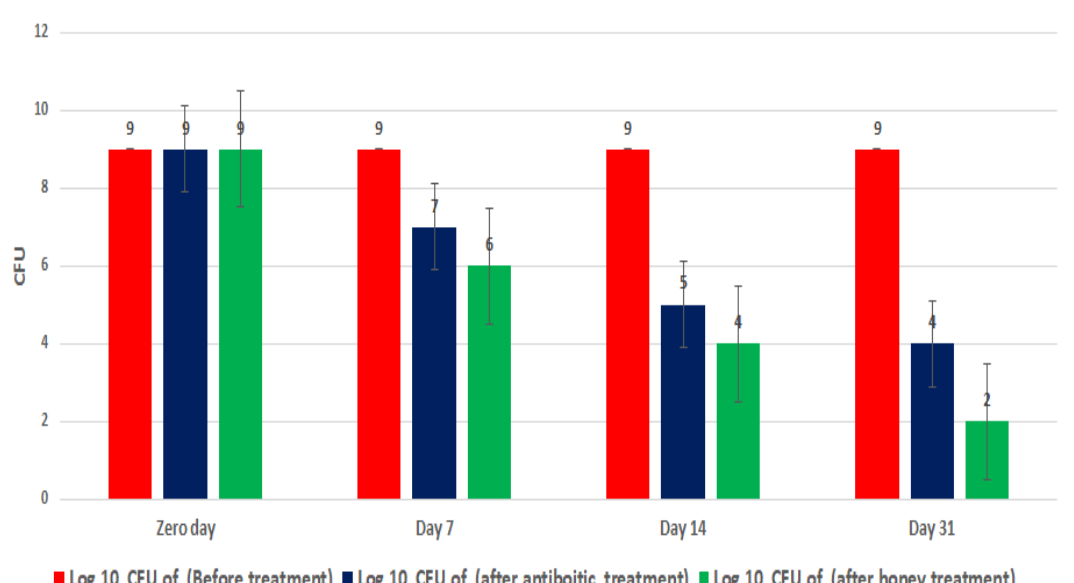
Figure 3. Log10 bacterial CFU and treatment with Saudi Arabia Qatada honey